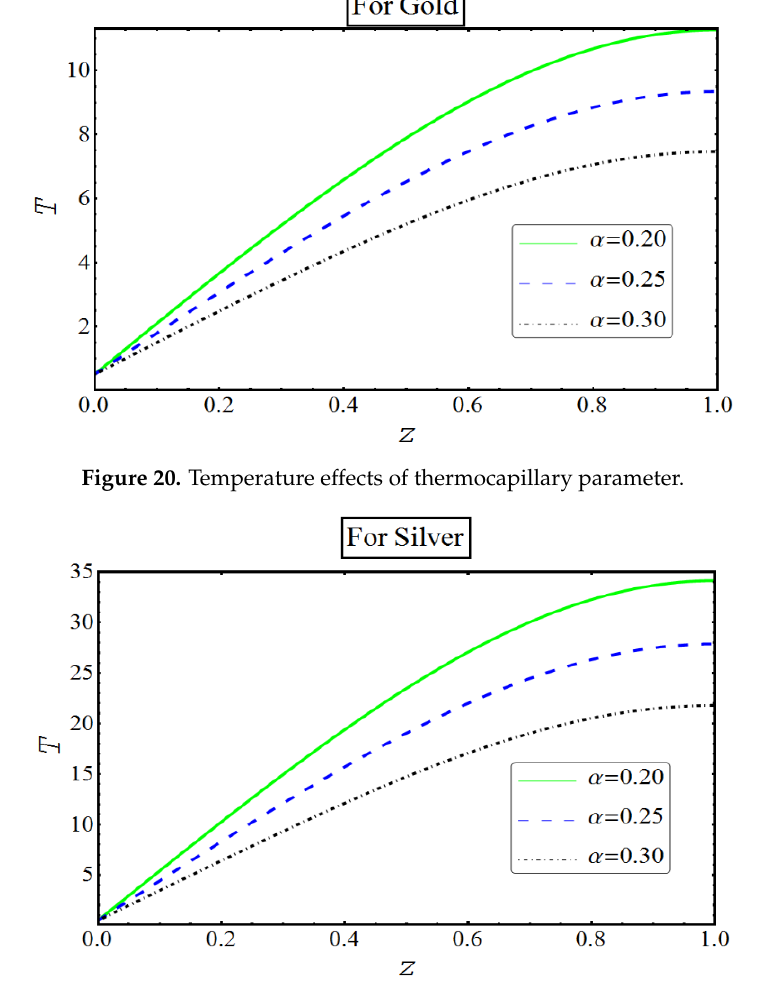
Figure 21 . Temperature effects of thermocapillary parameter.